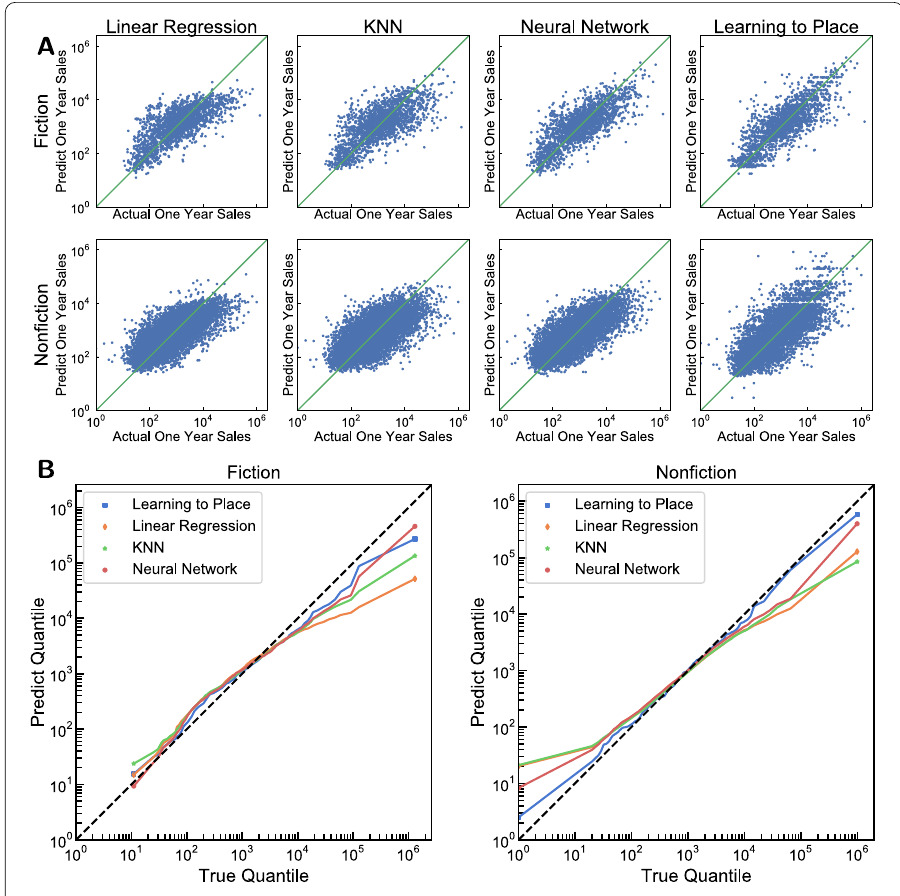
Figure 7 Model results of one year sales for fiction and nonfiction books. We compare LearningtoPlace against three baseline methods ( LinearRegression , KNN , NeuralNetwork ). ( A ) Actual vs prediction scatter plots. All three baseline methods systematically underpredict at high-end to a certain extent while this underprediction is absent in LearningtoPlace . ( B ) Quantile-Quantile plot. For fiction, on the high-end sales, neuralnetwork and LearningtoPlace are the closest to the ground truth (45 degree line). For nonfiction, LearningtoPlace is the closest to the ground truth. KNN and LinearRegression at the high-end systematically have lower predictive power for both fiction and